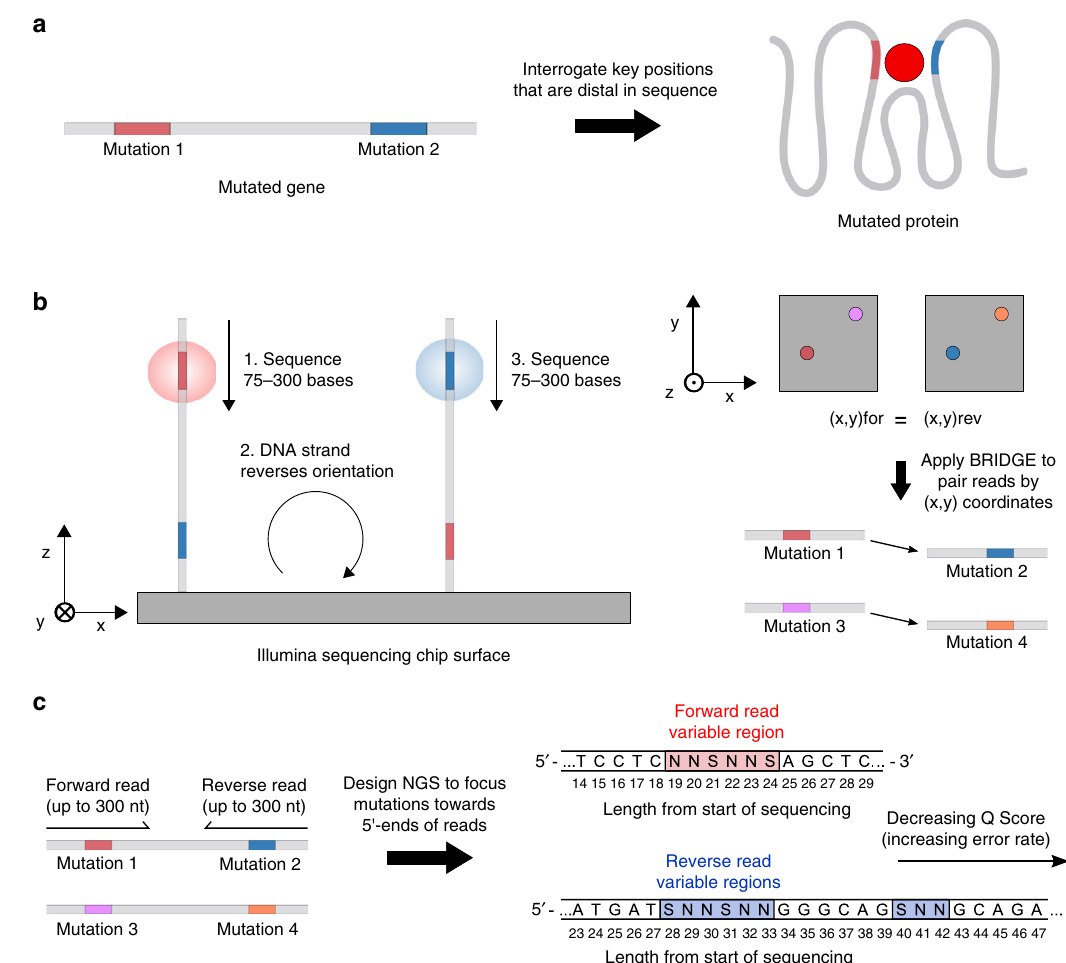
Fig. 1 Diagram of Illumina sequencing mechanism underlying BRIDGE. a New methods are needed to engineer key residues in active sites (e.g., ligand- binding domains) while accounting for epistatic interactions. b BRIDGE can be used to extensively quantify the enrichment of variants containing mutations at distal sites. In order to match nonoverlapping paired-end reads, we leverage the Illumina sequencing mechanism wherein reads generated from either end of the same DNA strand produce fl uorescent signals at the same ( x , y ) coordinate on the sequencing chip surface. By matching nonoverlapping read pairs using their surface coordinates, BRIDGE directly accounts for epistasis between distal residues in experiments reliant on next-generation sequencing. c High sequencing accuracy is obtained by designing NGS experiments such that variable regions are focused towards the 5 ′ -end of each read, where error rates are